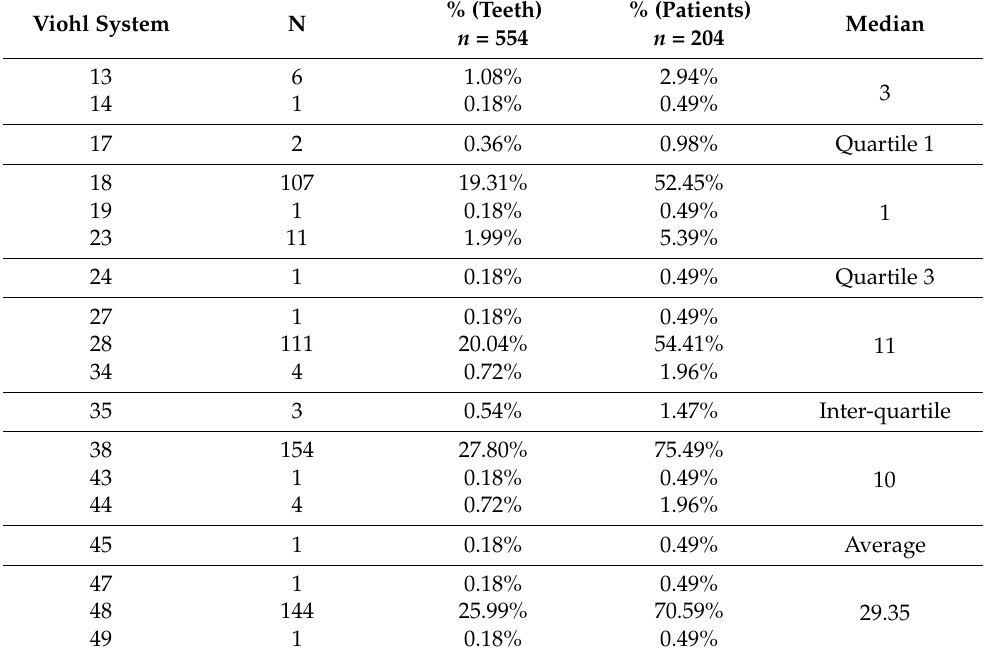
Table 2. Proportion of different tooth types (according to the Viohl system) in study group